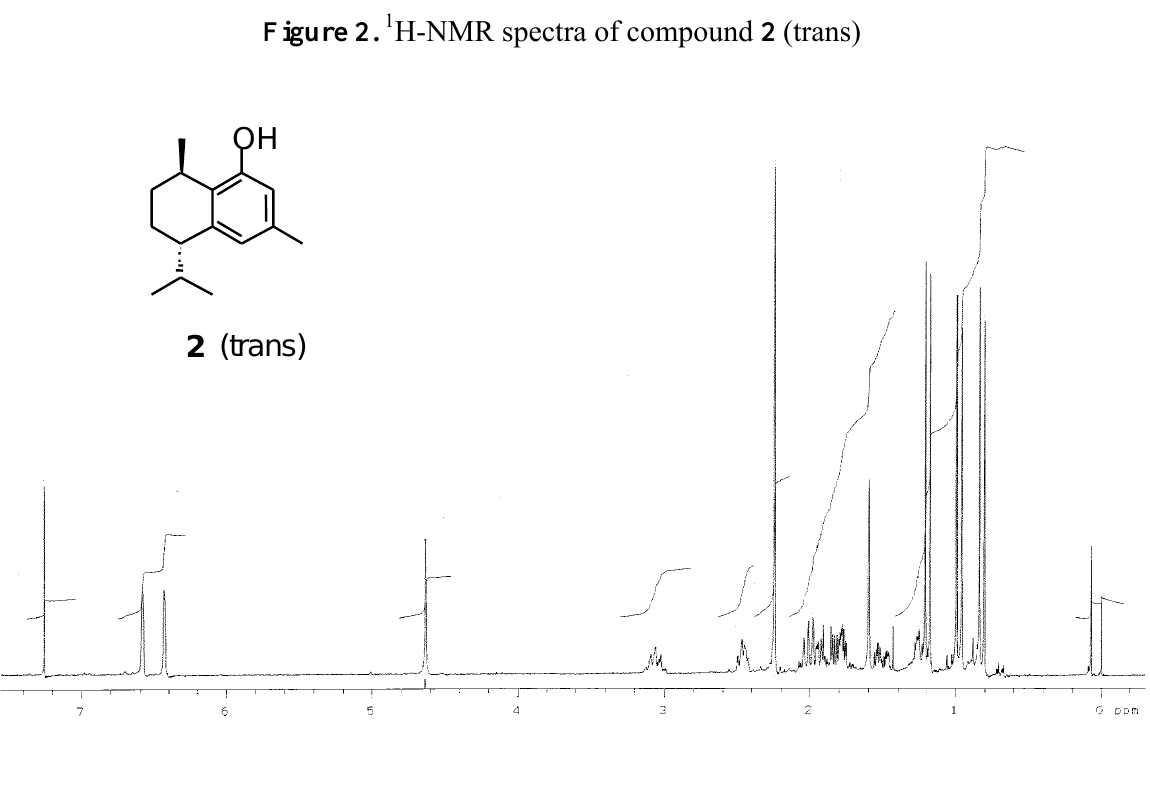
Figure 2. 1 H-NMR spectra of compound 2